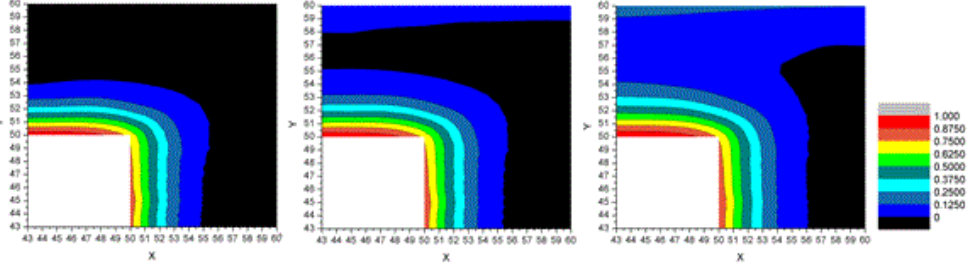
Figure 16 – Isoprobability of failure curves for corner H. Probability of failure values for 25 years, 50 years and 75 years. Dimensions in cm.